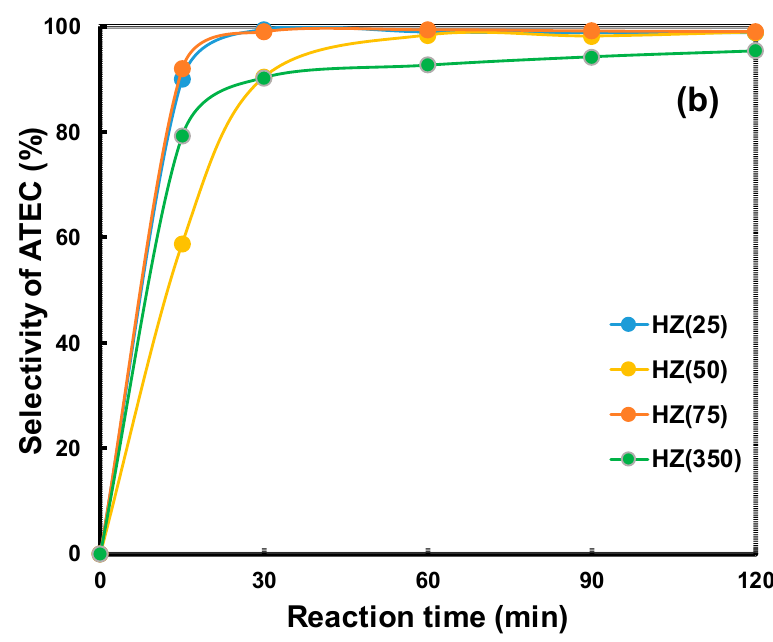
Figure 7. Conversion of TEC ( a ) and selectivity of ATEC ( b ) in the acetylation over HZSM-5 zeolites with various Si/Al molar ratios.